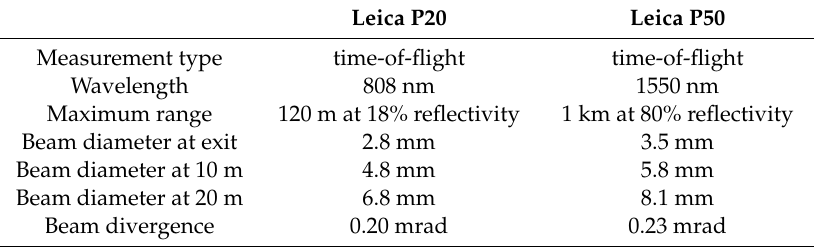
Figure 1. The TLS instruments used in this study: ( a ) The Leica P20 and ( b ) the Leica P50. The similarities in chassis, laser beam exit locations, and scanning mechanisms allow for the high registration accuracy of the point-clouds from the two instruments. Table 2. Technical specifications of the Leica P20 and P50 terrestrial laser scanning (TLS) instruments.